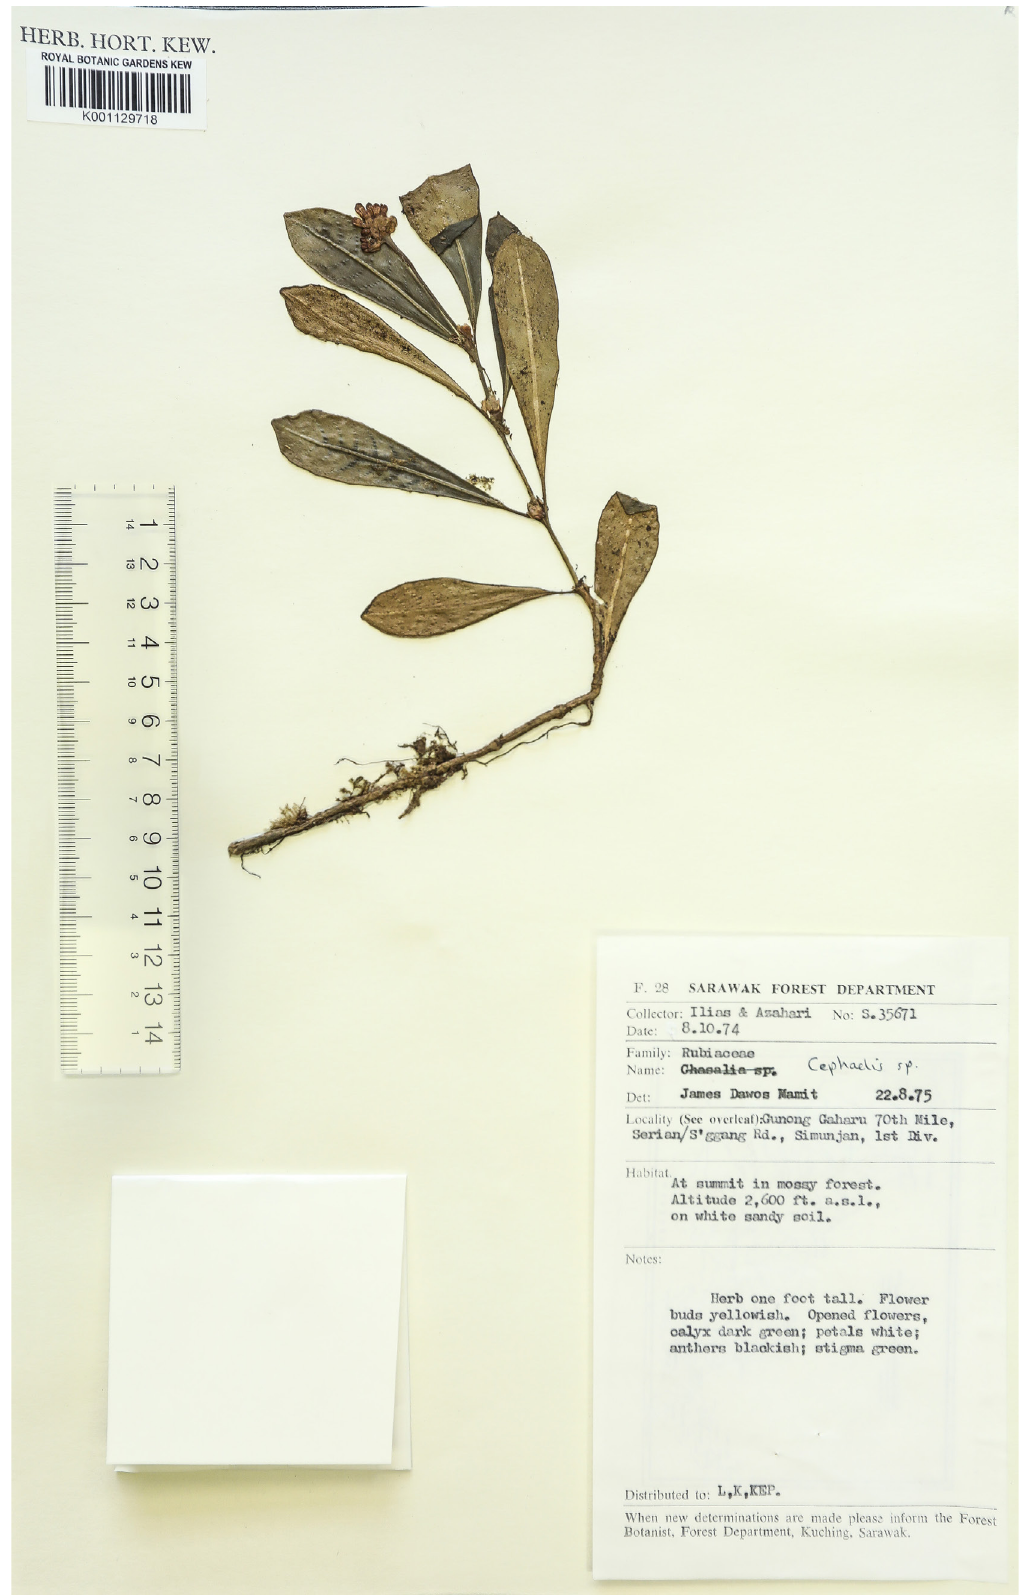
Fig. 27. Holotype of Chassalia muscicola T.Y.Yu sp. nov. ( Ilias & Azahari S 35671